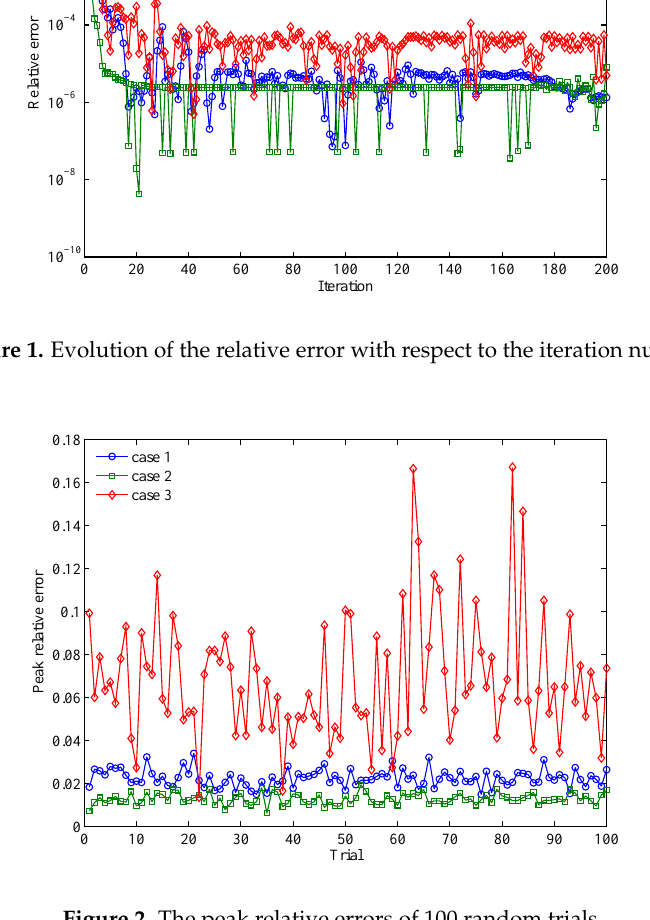
Figure 2. The peak relative errors of 100 random